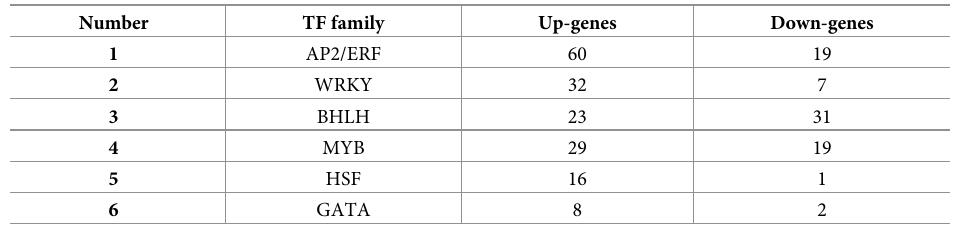
into functional groups consisting of 1,963 GO terms in biological processes, 405 GO terms in cellular components, and 1,186 GO terms in molecular function subcategories in the compari- son between treated and control IL7 samples. The biological process category represented 23 functional subcategories, out of which metabolic process, response to stimulus, and regulation of biological process were predominantly enriched under cold stress (Fig 3). The cellular Table 2. Major transcription factor in